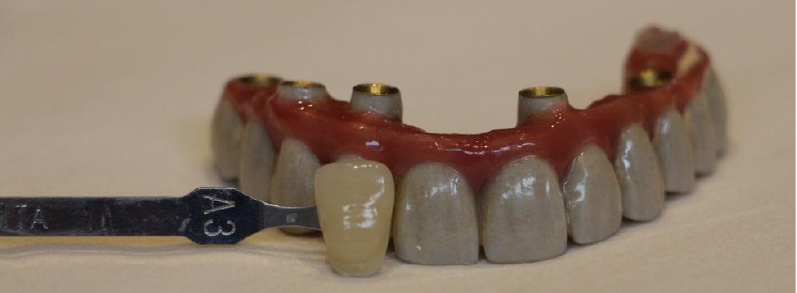
Figure 2. Color difference between A3 dental shade tab and hybrid provisional complete prothesis made of acetal resin. Table 1. Colour differences, according to the Euclidean and CIEDE2000 formulae, in the three thirds of the upper central incisor.